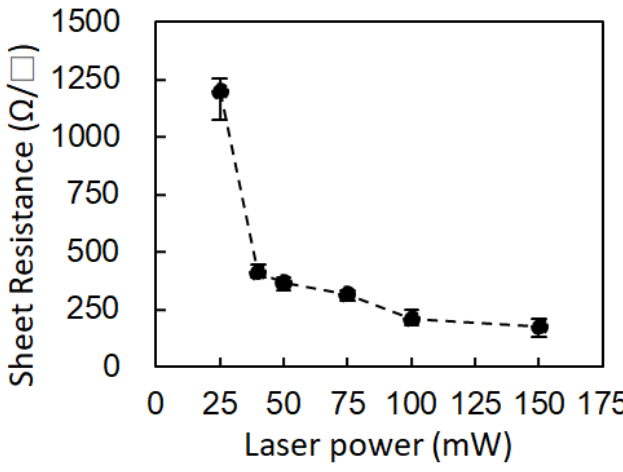
Figure 7. The sheet resistance of the laser-scripted rGO resistive film as a function of laser power. The fabricated terminations were examined by a vector network analyzer (ZVA67, Rohde & Schwarz) from 0.2 GHz to 30 GHz. A variation of the laser power from 40 mW to 50 mW was demonstrated by three samples with corresponding sheet resistances of 410 Ω/□, 383 Ω/□, and 365 Ω/□, respectively, simulating the fabrication-error-caused variations of the sheet resistance. The measured reflections (|S 11 |) in Figure 8 show high return losses. All samples provide a termination level of over − 10 dB at frequencies above 4.0 GHz, and a terminal level of over − 15 dB at frequencies above 6.0 GHz. This confirms the efficacy of the design and the fabrication process, and the functionality of the resulting terminations.